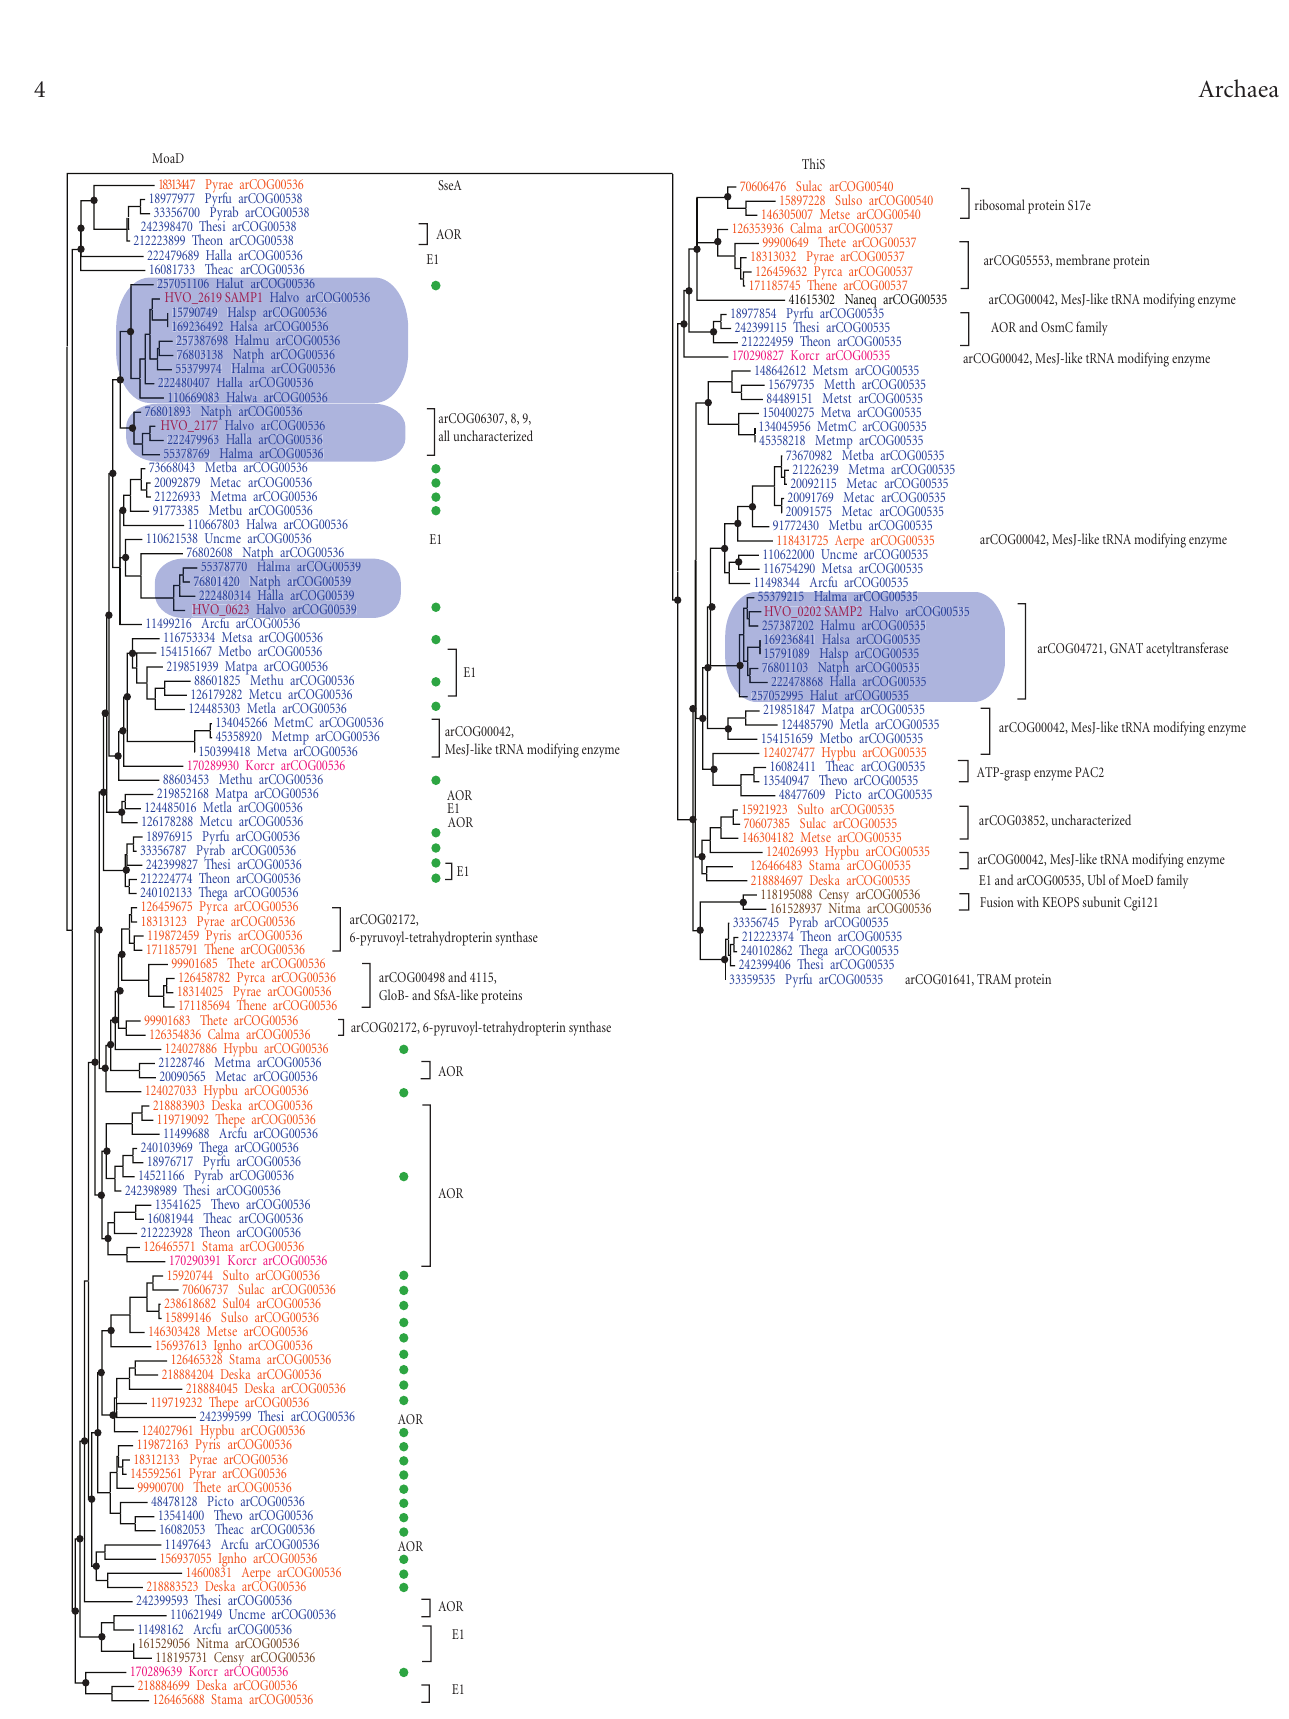
Figure 1: The phylogenetic tree and gene associations for the archaeal Ubl proteins of the β -grasp